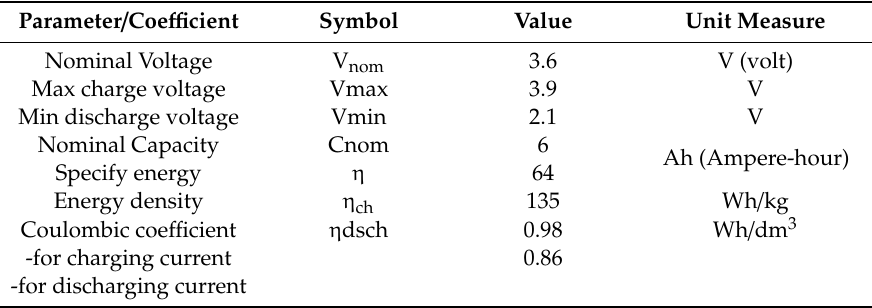
Table 1. Li-ion electrical characteristics for a SAFT battery of 6 Ah, 3.6 V